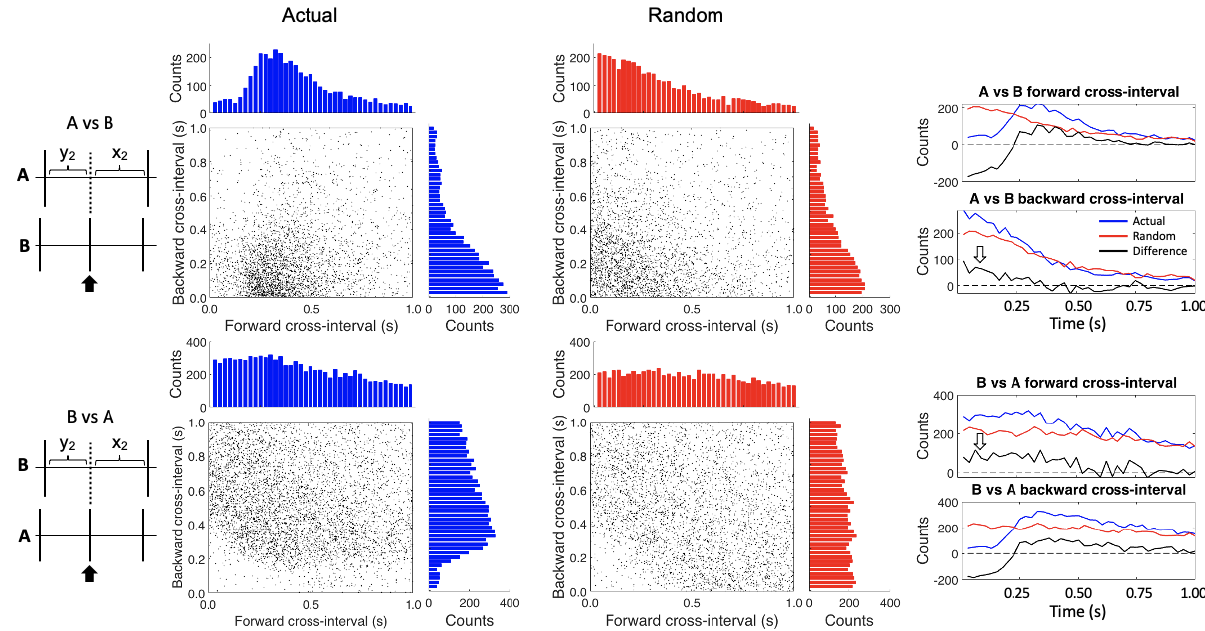
Figure 4. Conditional cross-interval plots. The A spikes are referenced against the B spikes in the upper plots while the reverse is true in the lower plots. The left hand (blue) plots show the actual data while the right hand (red) plots were created after randomizing the interspike intervals for each of the spike trains. The histograms on the tops and the sides of the plots show the counts by time bin for each axis. The four graphs on the right show the differences (black lines) between the actual (blue lines) and randomized data (red lines) for both the forward and backward cross intervals. The open white arrows highlight areas of increased activity in the difference